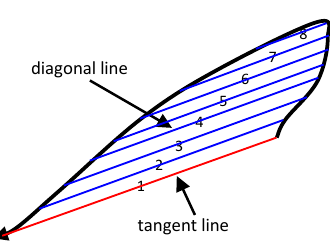
Figure 8. The inside space of V-shaped curve is divided into parts with diagonal lines along the direction of its tangent line.